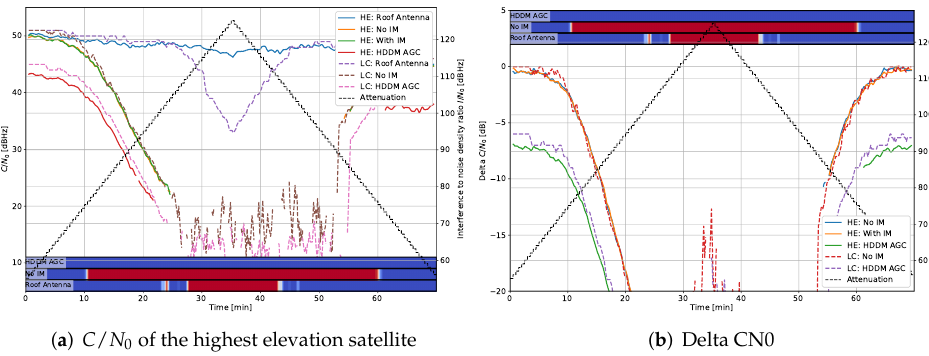
Figure A16. Interference #7: Filtered noise with 35MHz bandwidth with Galileo E1BC.